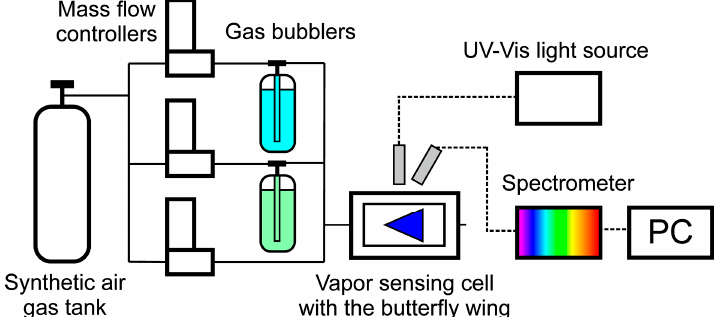
Figure 1. Schematic drawing of the measurement setup used in the vapor sensing experiment. Digital mass flow controllers were used to set the concentration of the vapor mixtures by letting synthetic air through the gas bubblers (blue: water, green: volatile component) in the desired ratio to the vapor sensing cell which contained the butterfly wing. The optical response of the wings was measured by a modular spectrophotometer.